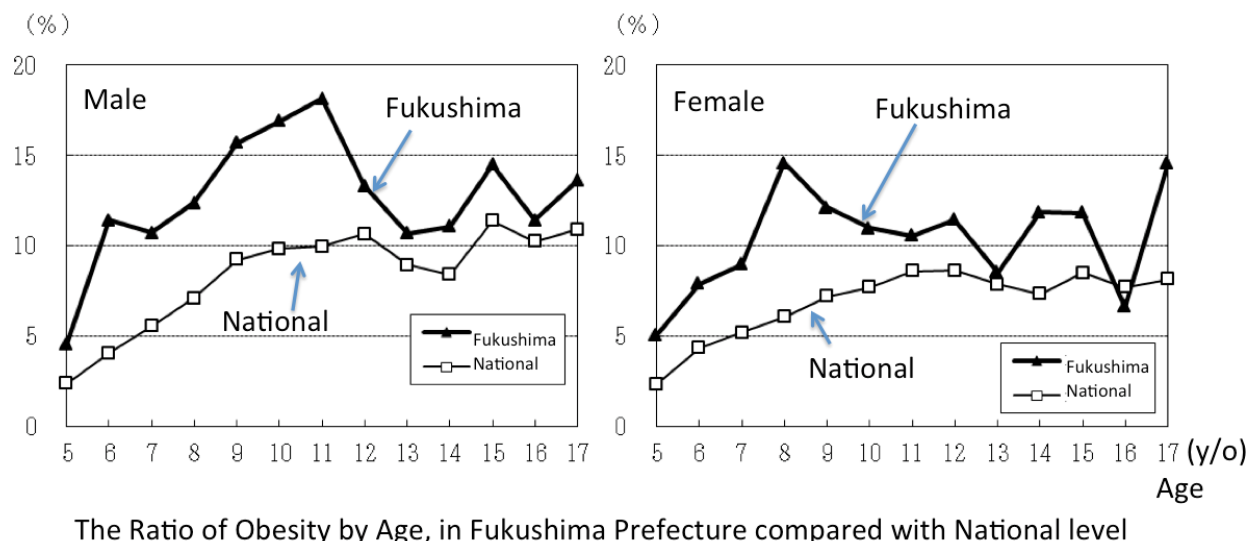
Figure 5. The difference of the ratio of obesity by age in Fukushima prefecture. (This is arranged from the original graph made by the department of statistics of Fukushima prefecture with the permission to